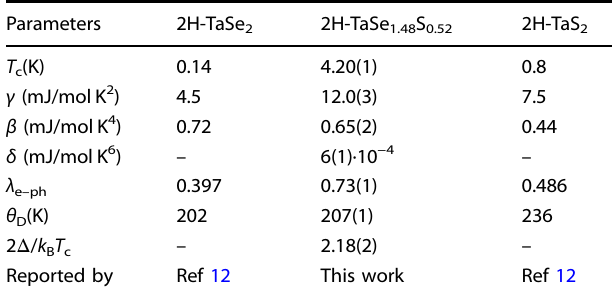
Table 1. Superconducting parameters of 2H-TaSe 2 , 2H-TaSe 1.48 S 0.52 , and